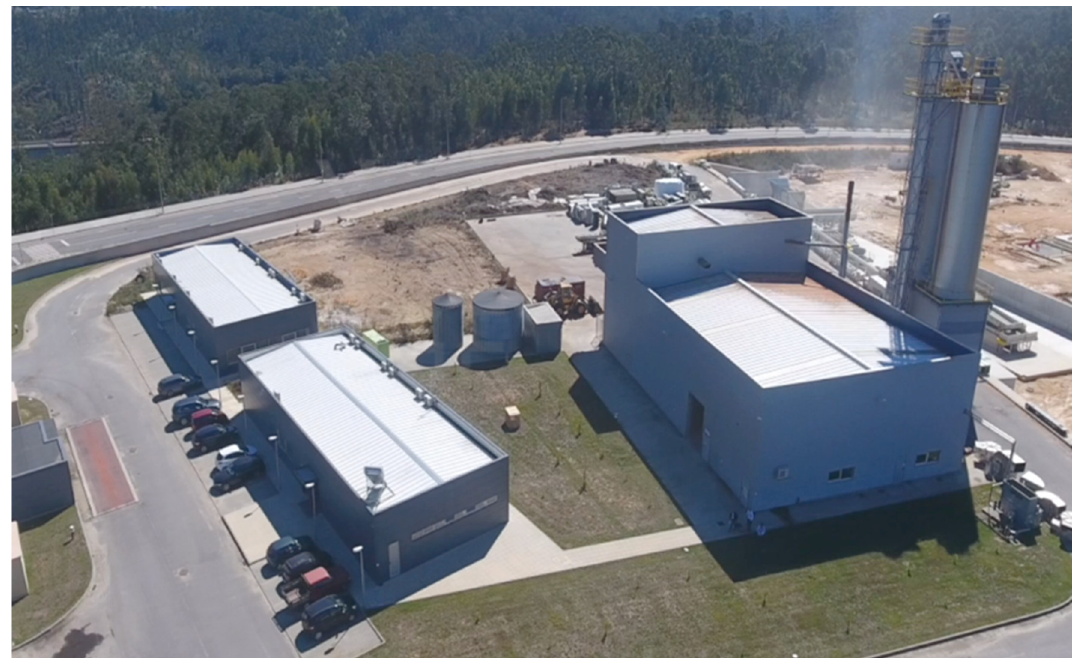
Figure 1. Exterior of the YGE—Yser Green Energy SA torrefied biomass production unit in full operation, in the locality of Oliveira de Azeméis, in the district of Aveiro (North of Portugal).